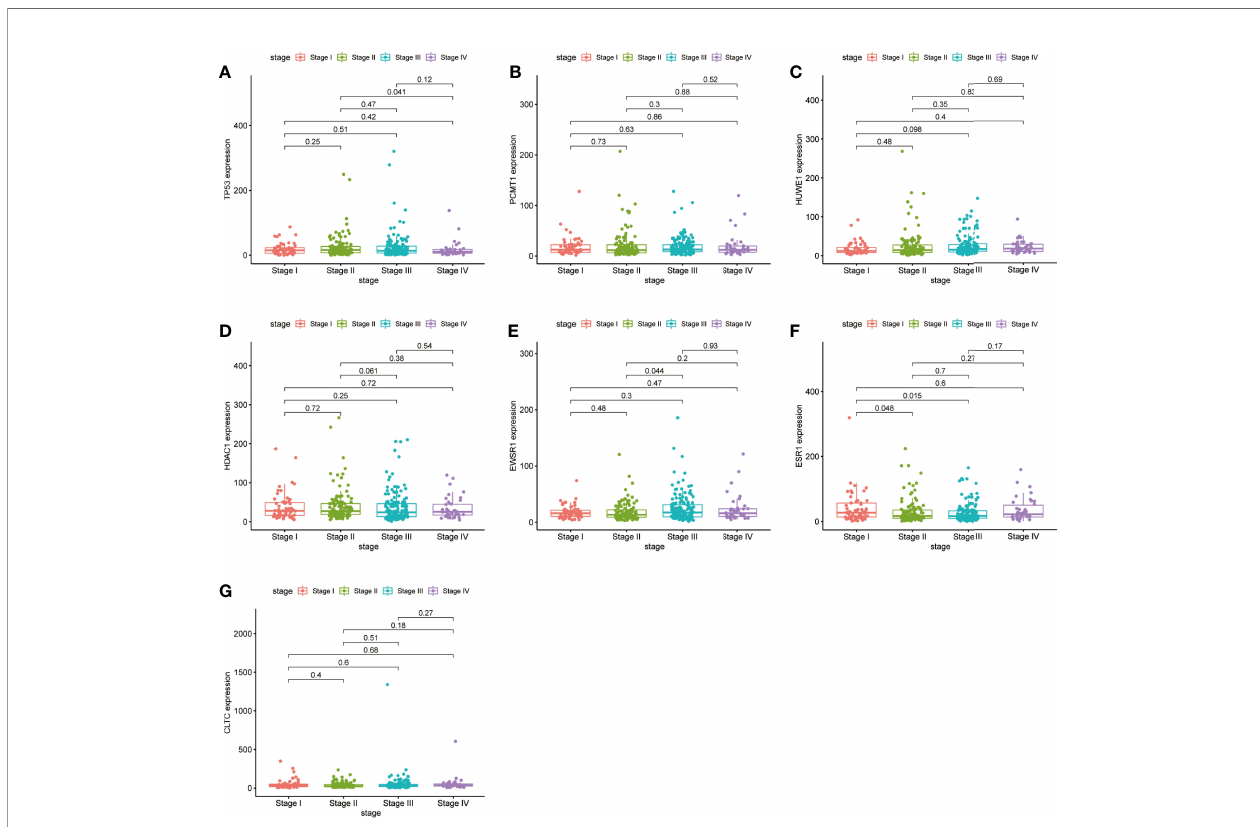
FIGURE 8 | Validation of the expression levels of the seven hub genes of TCGA tissues from the TCGA database. (A) Gene expression value of TP53 among samples of TCGA. (B) Gene expression value of PCMT1 among samples of TCGA. (C) Gene expression value of HUWE1 among samples of TCGA. (D) Gene expression value of HDAC1 among samples of TCGA. (E) Gene expression value of EWSR1 among samples of TCGA. (F) Gene expression value of ESR1 among samples of TCGA. (G) Gene expression value of CLTC among samples of TCGA. P < 0.05 was considered to be a statistically signi fi cant